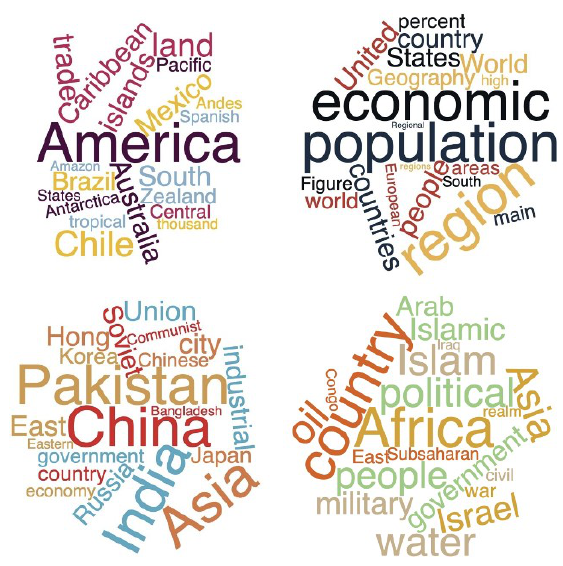
Figure 6. Word clouds with the top 20 keywords related to the 4 respective topics.